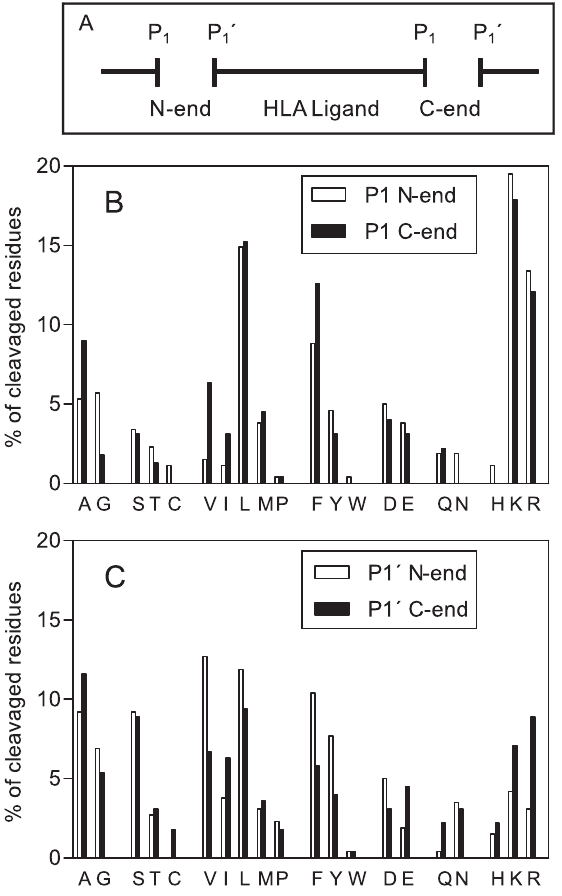
Figure 2. Analysis of N- and C-end cleavage specificity in HLA class I ligands. A diagram of residues involved in the generation of naturally processed HLA class I ligands by peptidase cleavages is shown (panel A). Distribution of P 1 (panel B) and P 9 1 (panel C) amino acid residues of the scissile bonds created by peptidase cleavage.